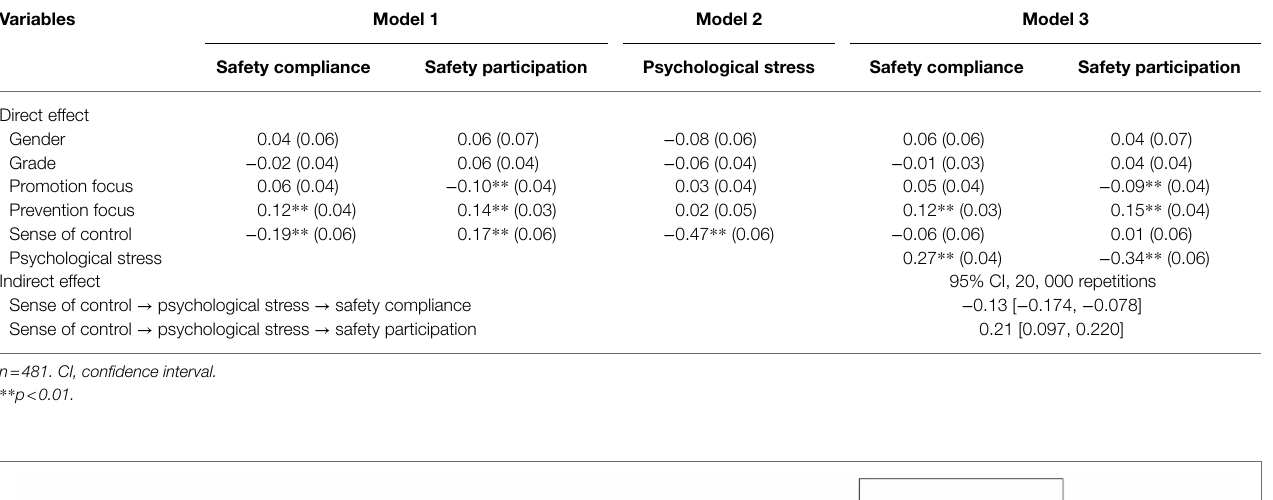
TABLE 3 | Meditation effect analysis.